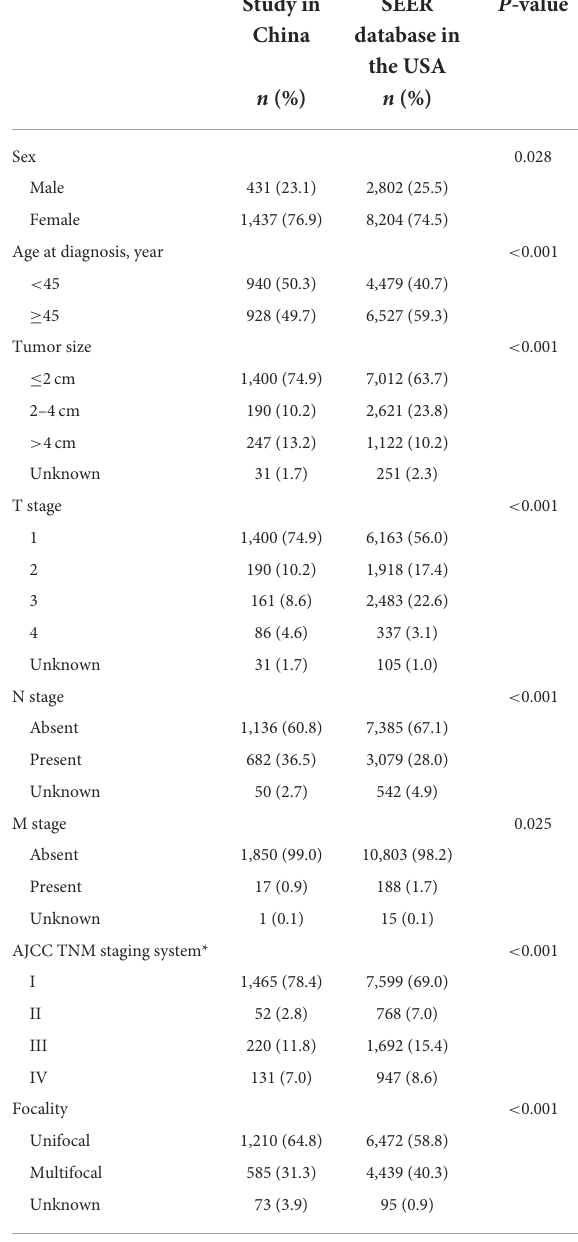
TABLE 4 Comparisons of clinicopathological features of DTC patients between the study in China and SEER database in the USA. Study in China